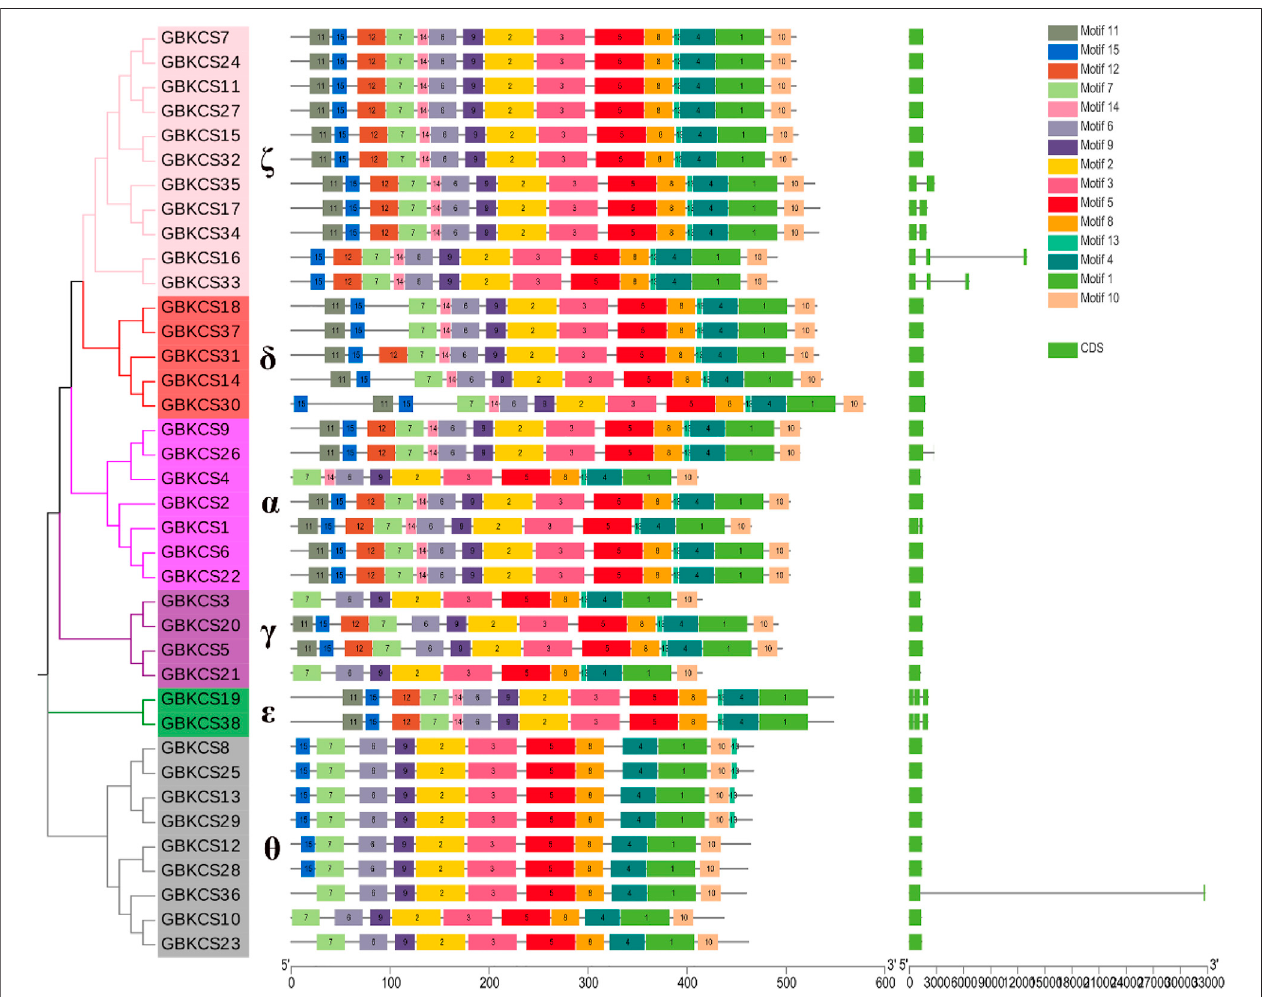
FIGURE 2 | Conserved motifs and exon-intron organization of KCS genes from G. barbadense